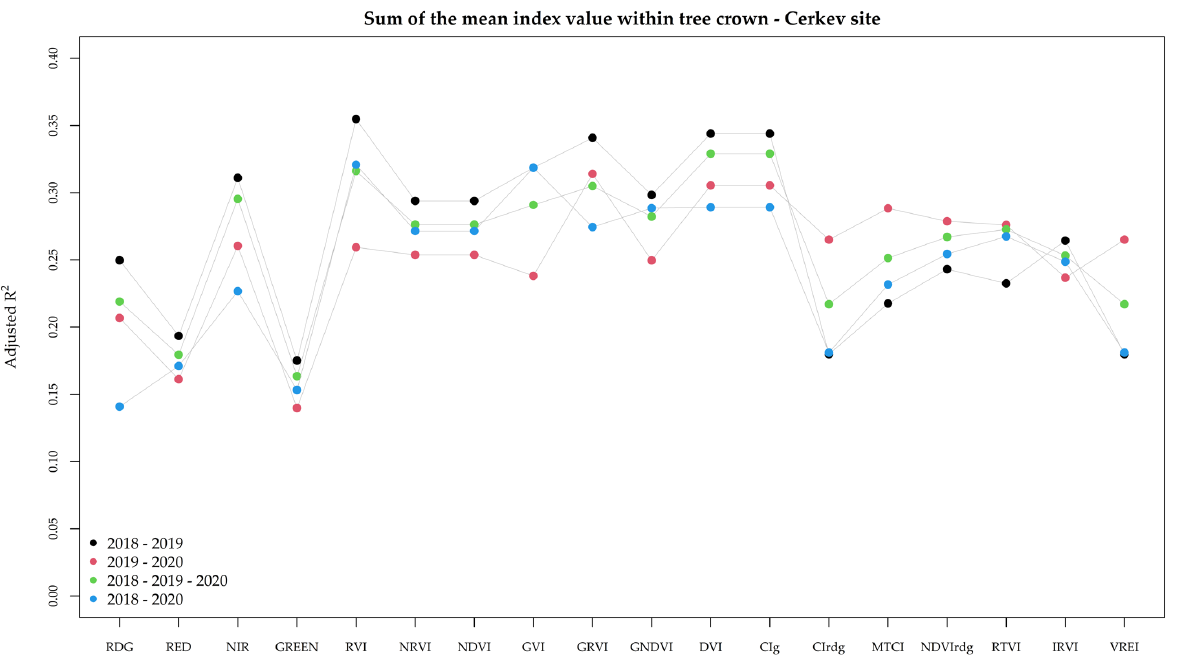
Figure 10. The sum of mean index values at the Cerkev site of the tree crowns and the